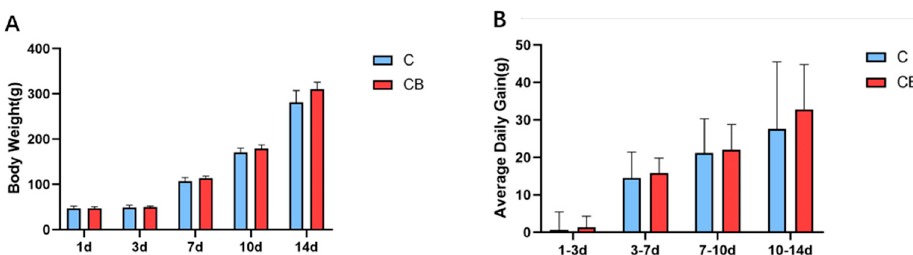
Figure 1. The early intervention of C. butyricum had no significant effect on the growth performance of Muscovy ducks. ( A ) The BW of the Muscovy ducks on Days 1, 3, 7, 10, and 14 (displayed as 1d, 3d, 7d, 10d, and 14d, respectively). ( B ) The ADG of the Muscovy ducks in different time periods. Data were expressed as the mean ± SD ( n = 8) and analyzed by the unpaired two-tailed Student’s t -test. C, control group; CB, C. butyricum group.